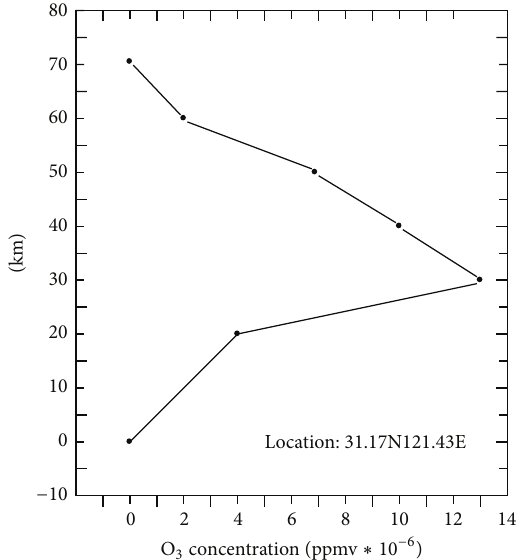
Figure3:TheanalysisofO 3 Concentrationvariationultravioletrays in the atmosphere.